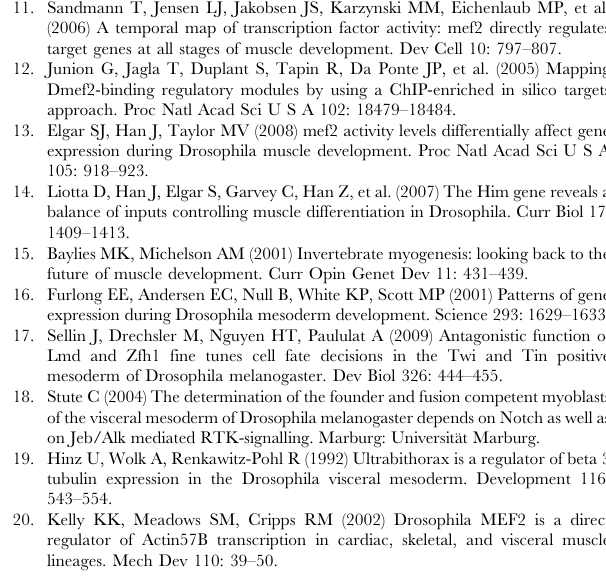
Figure S2 Ectopic expression of Lmd and Mef2 reveals differential regulatory input on target gene expression. Double fluorescent in situ hybridisation (FISH) of the gene of interest (green) and endogenous wg gene (red). Ectopic expression (using the engrailed GAL4 driver) should be visible juxtaposed to the wg stripe. The wg expression was therefore used to ensure that the confocal imaging was performed with identical laser and gain settings for each gene within the four genetic backgrounds. (A–I) FISH of wild-type embryos with probes specific for (A) b Tub60D , (B) act57B , (C) CG5080 , (D) blow , (E) sug , (F) sns , (G) CG14687 , (H) CG9416 , and (I) gol , detecting specific expression in the mesoderm. No specific staining was observed in the ectoderm (white brackets).